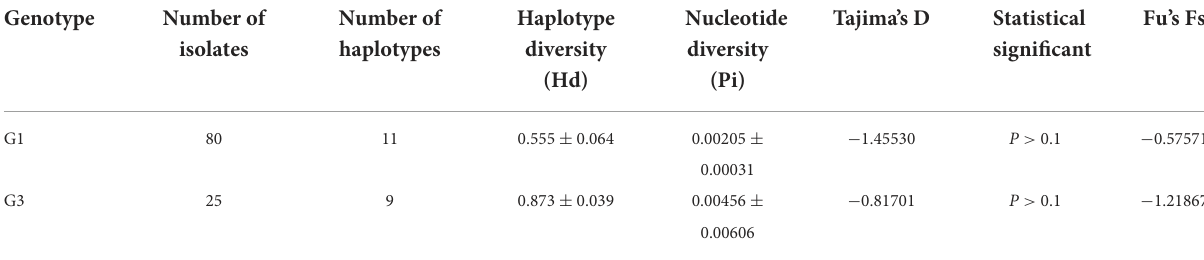
TABLE 2 Diversity and neutrality indices obtained using nucleotide data of the E. granulosus s.s. cox 1